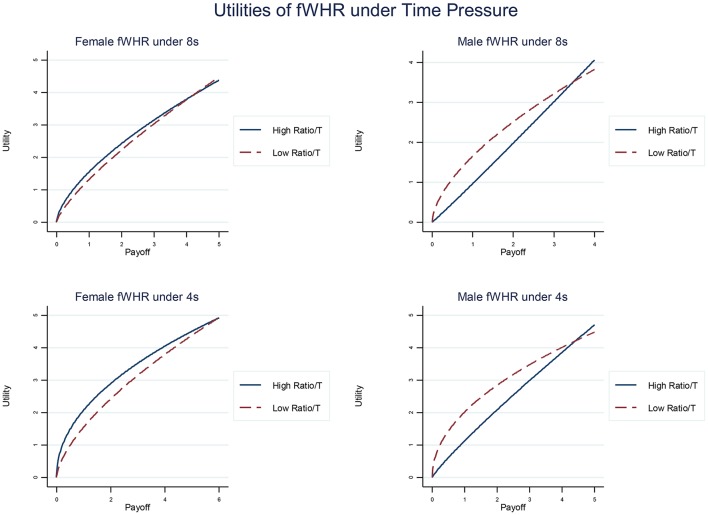
Estimated utility functions of fWHR separated by male and female sub-group and 8 and 4 s time phases. Male participants with high ratio become visibly less risk averse (the curve concavity indicates risk aversion).7